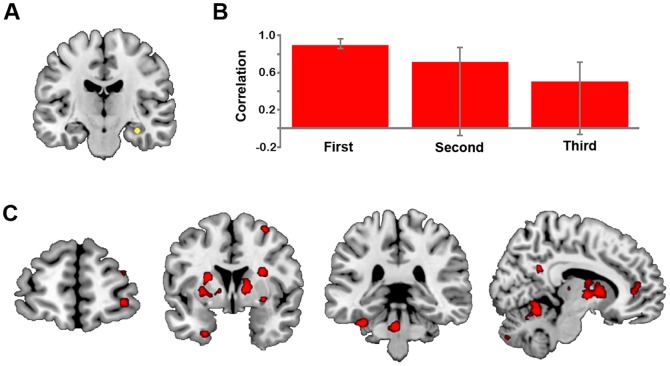
Results from functional connectivity analyses.(A) Location of the RHC seed (xyz 32 −16 −18). (B) Average brain scores indicating the strength of correlation between activity in the seed region and the associated whole brain network, with 95% confidence intervals for the First, Second and Third presentations (p = .05). (C) Regions which were significantly connected with the RHC seed during First, but not during Second and Third during TR 5, including: right frontopolar cortex (leftmost image), putamen, cerebellum and lingual gyrus (middle images), posterior cingulate cortex, thalamus and right medial frontal gyrus (rightmost image). These data are thresholded using a BSR of 5, which corresponds to p<.0001.